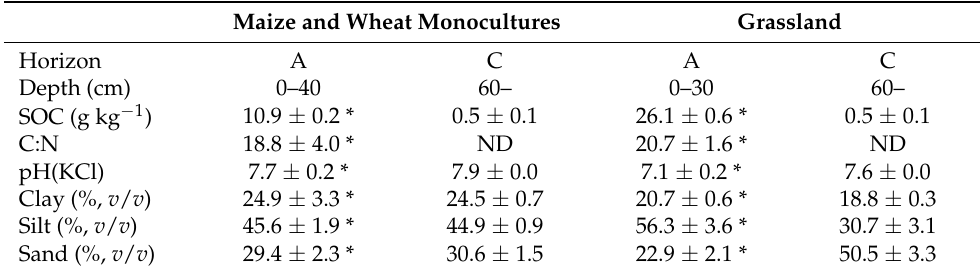
Table 1. Main parameters of the studied soils [22]. Values are means ± SE. The profiles included A, and C horizons. SOC: soil organic carbon; TN: total bound nitrogen; clay: <5 µ m fraction; silt: 5 µ m–50 µ m fraction; sand: 50 µ m–2000 µ m; ND: not determined; * measurements were made in the top 10